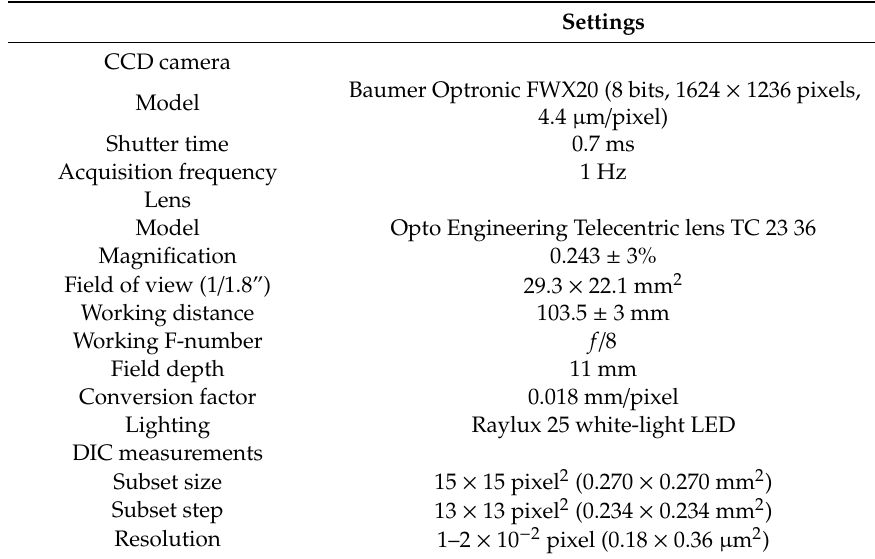
Figure 2. ENF test set-up coupled with DIC ( left ); and speckle pattern detail ( right ). Table 2. DIC parameters.